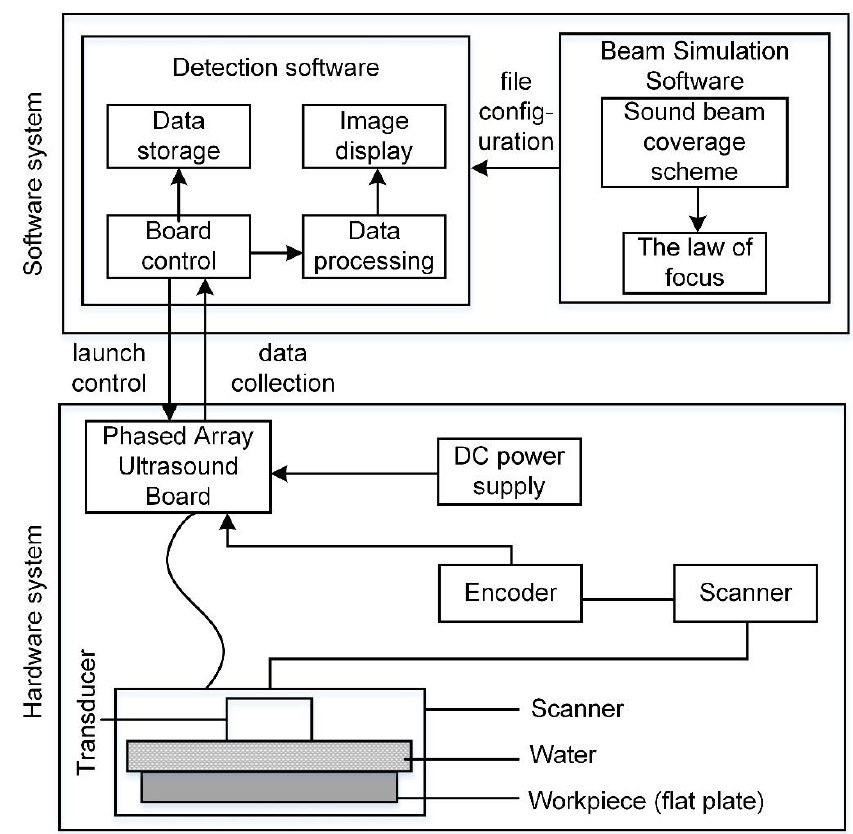
Figure 11. Overall structure of the detection system [103].